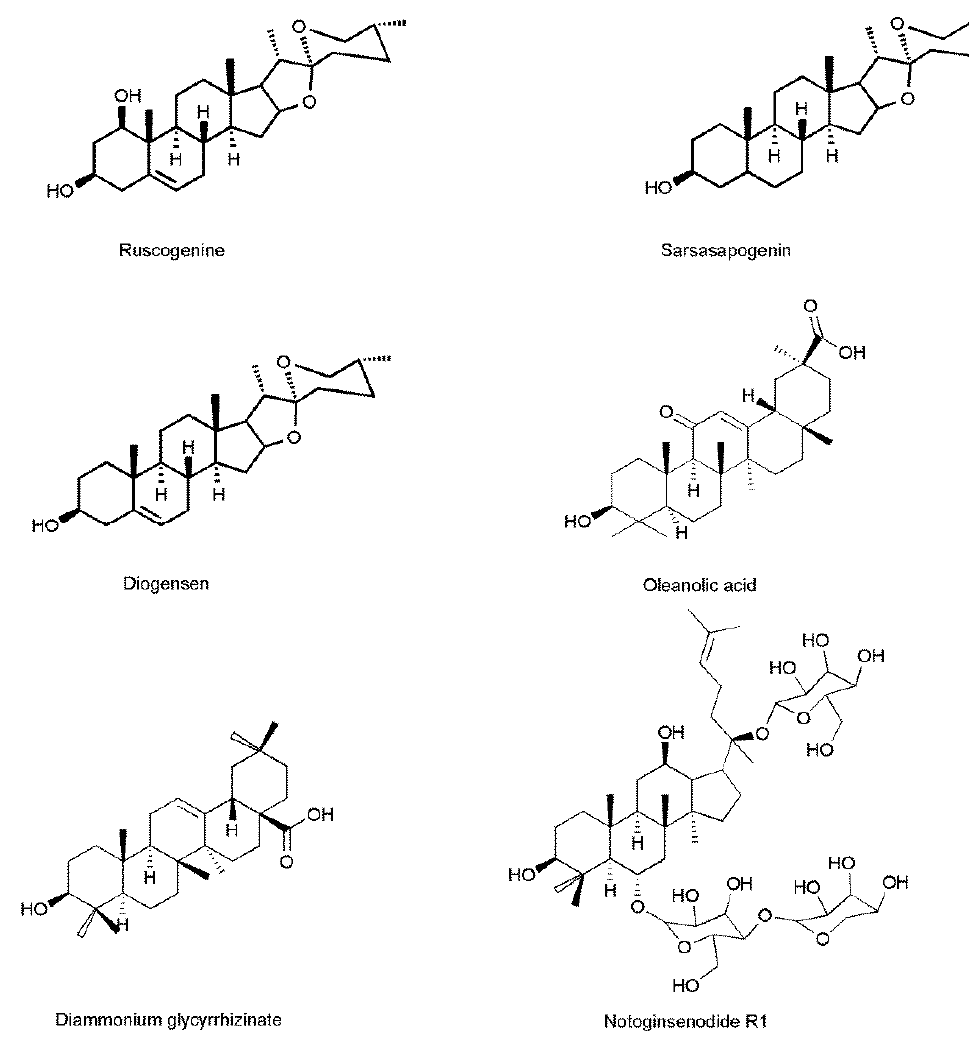
Figure 5. The structure of RUS and the analogues of RUS. Table 3. Calibration curves for RUS in different biological samples.